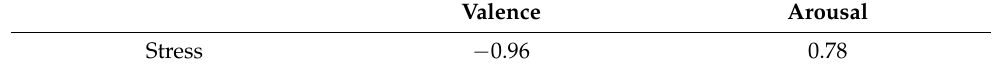
Table 4. Pearson’s correlation coefficient between stress with two dimensions of valence and arousal.